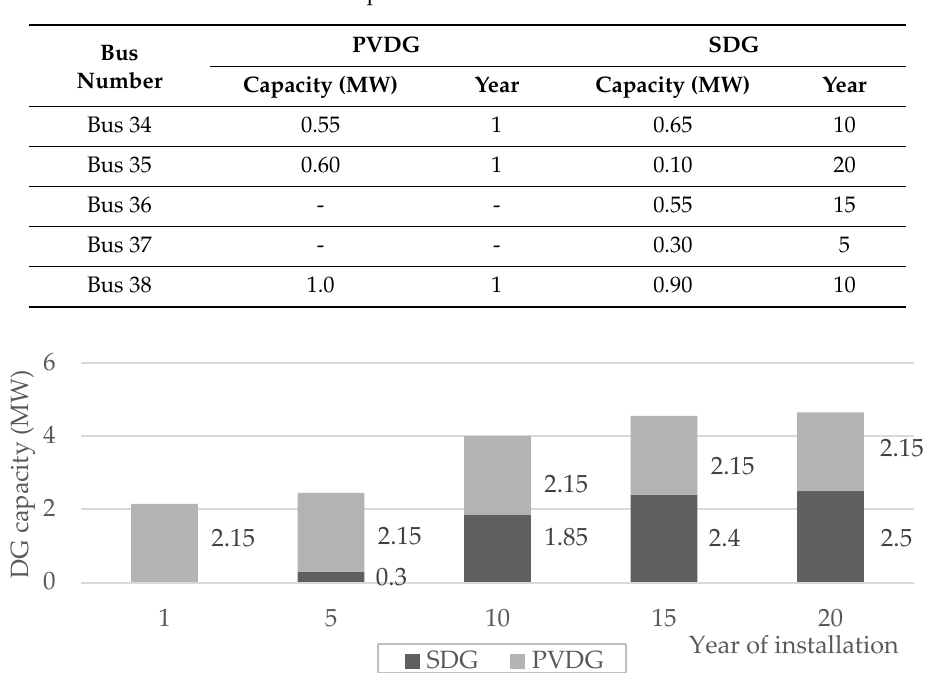
Table 2. Optimal Allocation of DG Units.